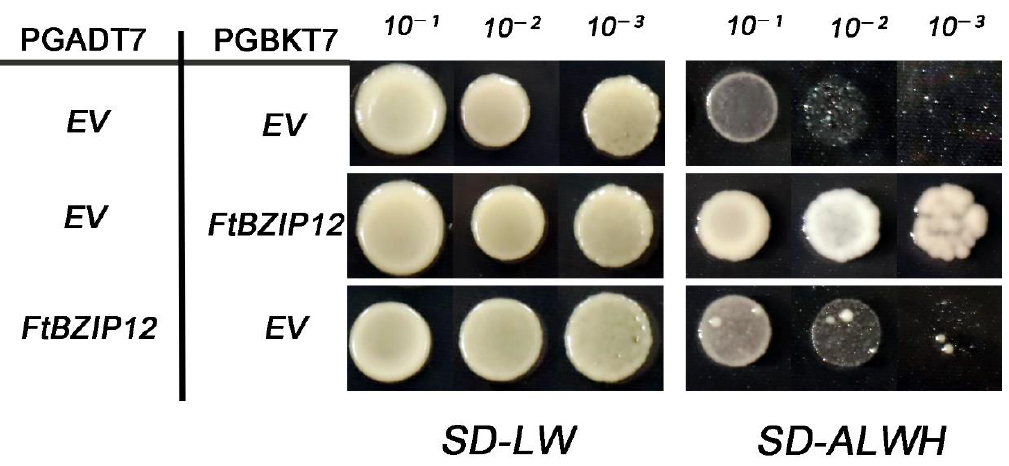
Figure 3. Identification of the transcriptional activation in FtbZIP12 . Fusion proteins of FtbZIP12 -pGBKT7 + pGADT7/ FtbZIP12 -pGADT7 + pGBKT7 were co-transformed into Y2HGold cells and grown on SD-LW or SD-ALWH plates to check their growth status. PGADT7 + PGBKT7 was used as the negative control. SD-LW: -trp and -leu; SD-ALWH: -trp, -leu, and -his. The experiment was repeated three times.